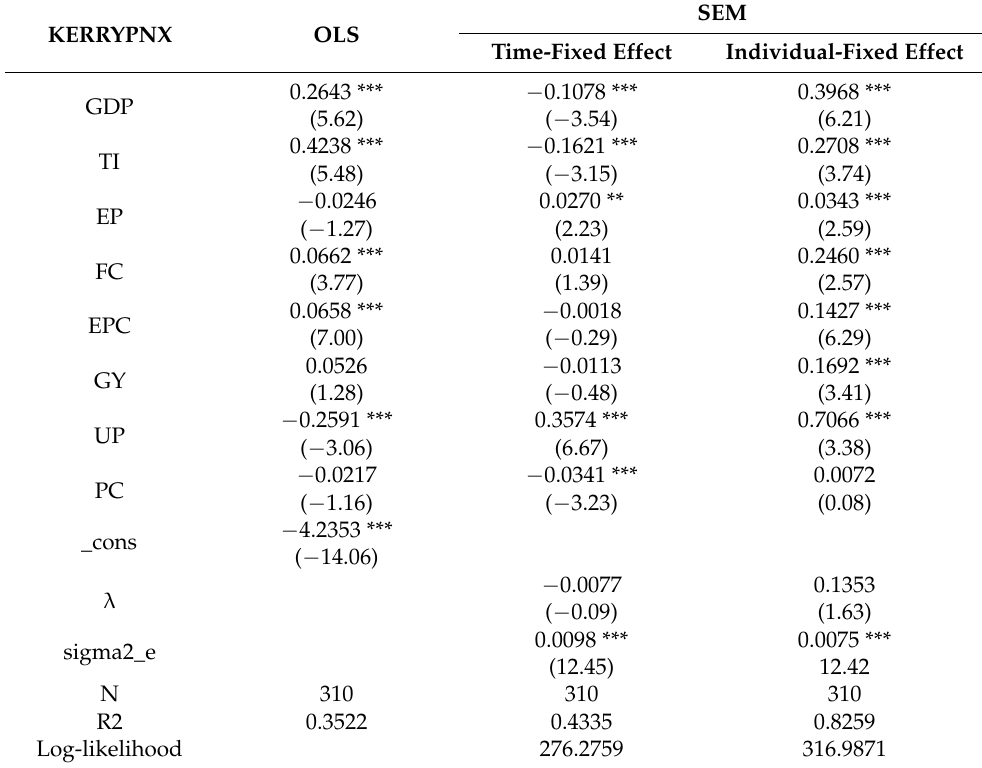
Table 8. Regression